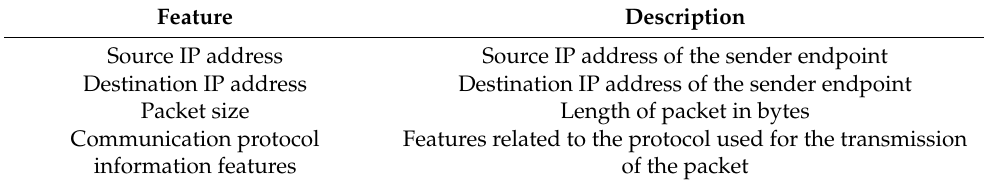
Table 7. Summary of features collected by the network data collection module of the CD component, and their